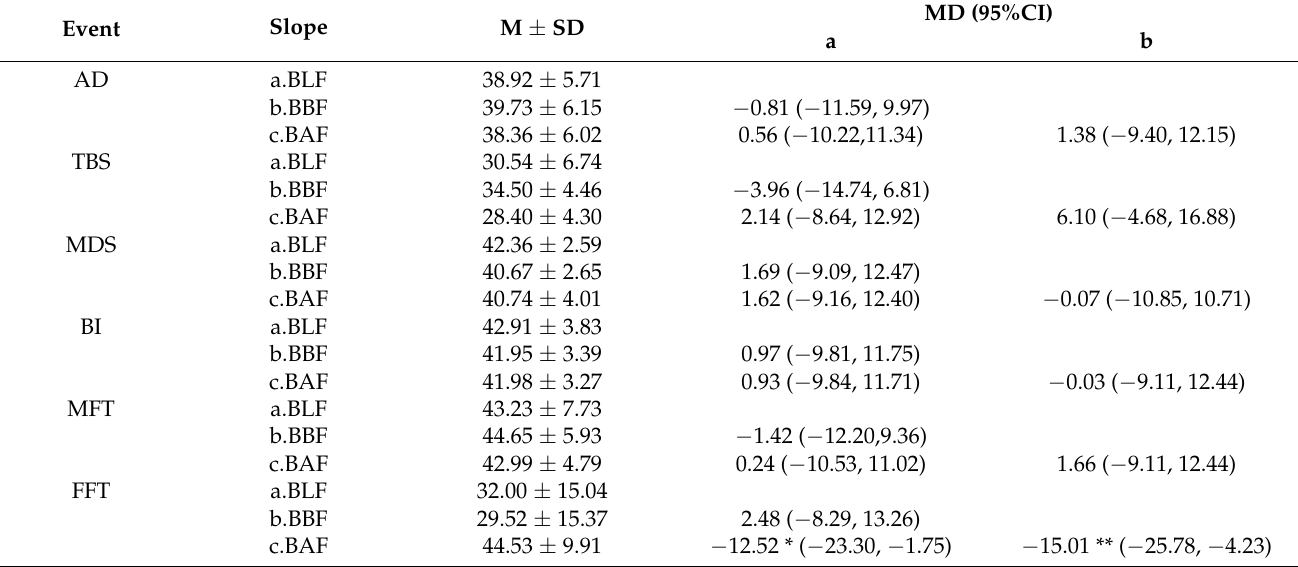
Figure 5. Trunk angles in sagittal and frontal planes. Comparisons of BLF, BBF, and BAF during AD, TBS, MDS, BI, MFT, and FFT (For sagittal plane, + stands for flexion, − stands for extension; For frontal plane, + stands for left lateral bending, − stands for right lateral bending). * p < 0.05, ** p < 0.01. Table 4. Trunk angle in sagittal results for the BLF, BBF, and BAF at different events.